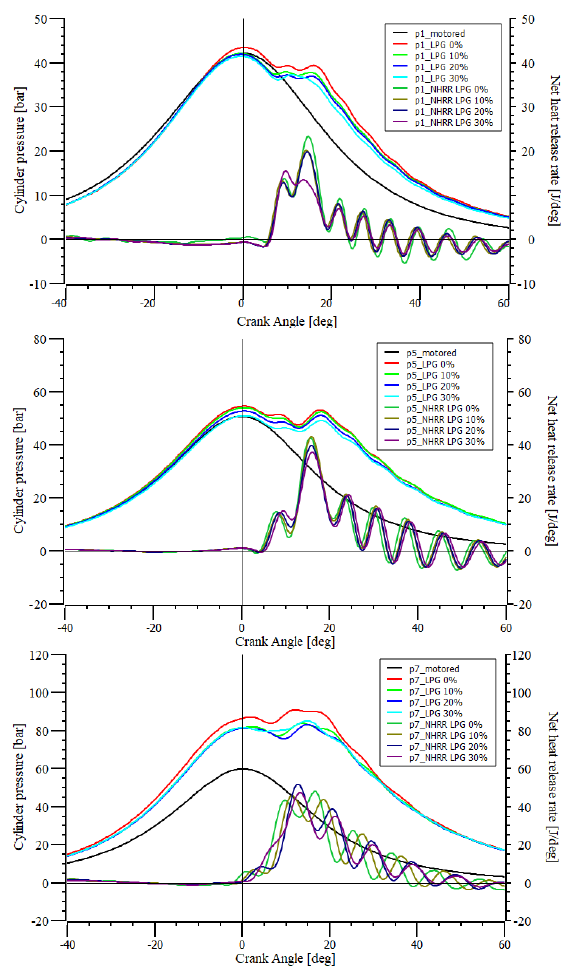
Fig. 10. Cylinder pressure and net heat release rate